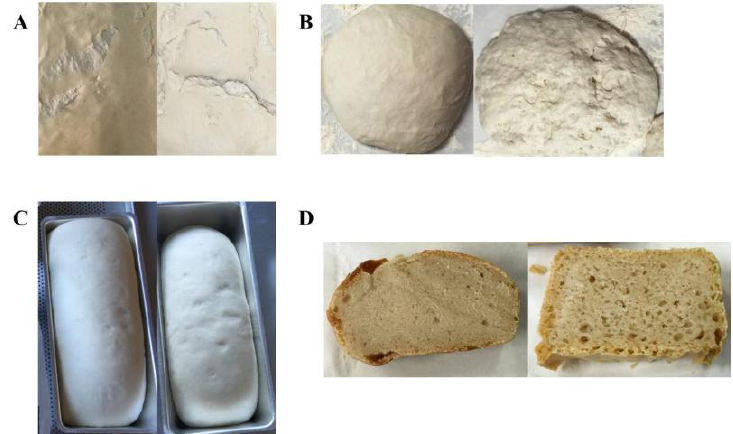
Figure 1. Dough fermented by S. cerevisiae “Lievital” (left pictures) or co-fermented with L. plantarum UFG 121 (right pictures) after ( A ) first fermentation step for 18 h at 30 °C, ( B ) kneading and shaping, ( C ) the final fermentation step for 90 min at room temperature, and ( D ) baking and cutting.